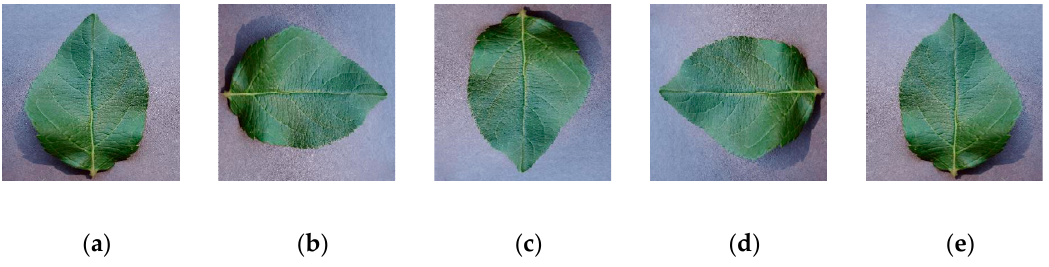
Figure 9. Direction disturbance: ( a ) initial, ( b ) 90, ( c ) 180, ( d ) 270, ( e ) horizontal flip.